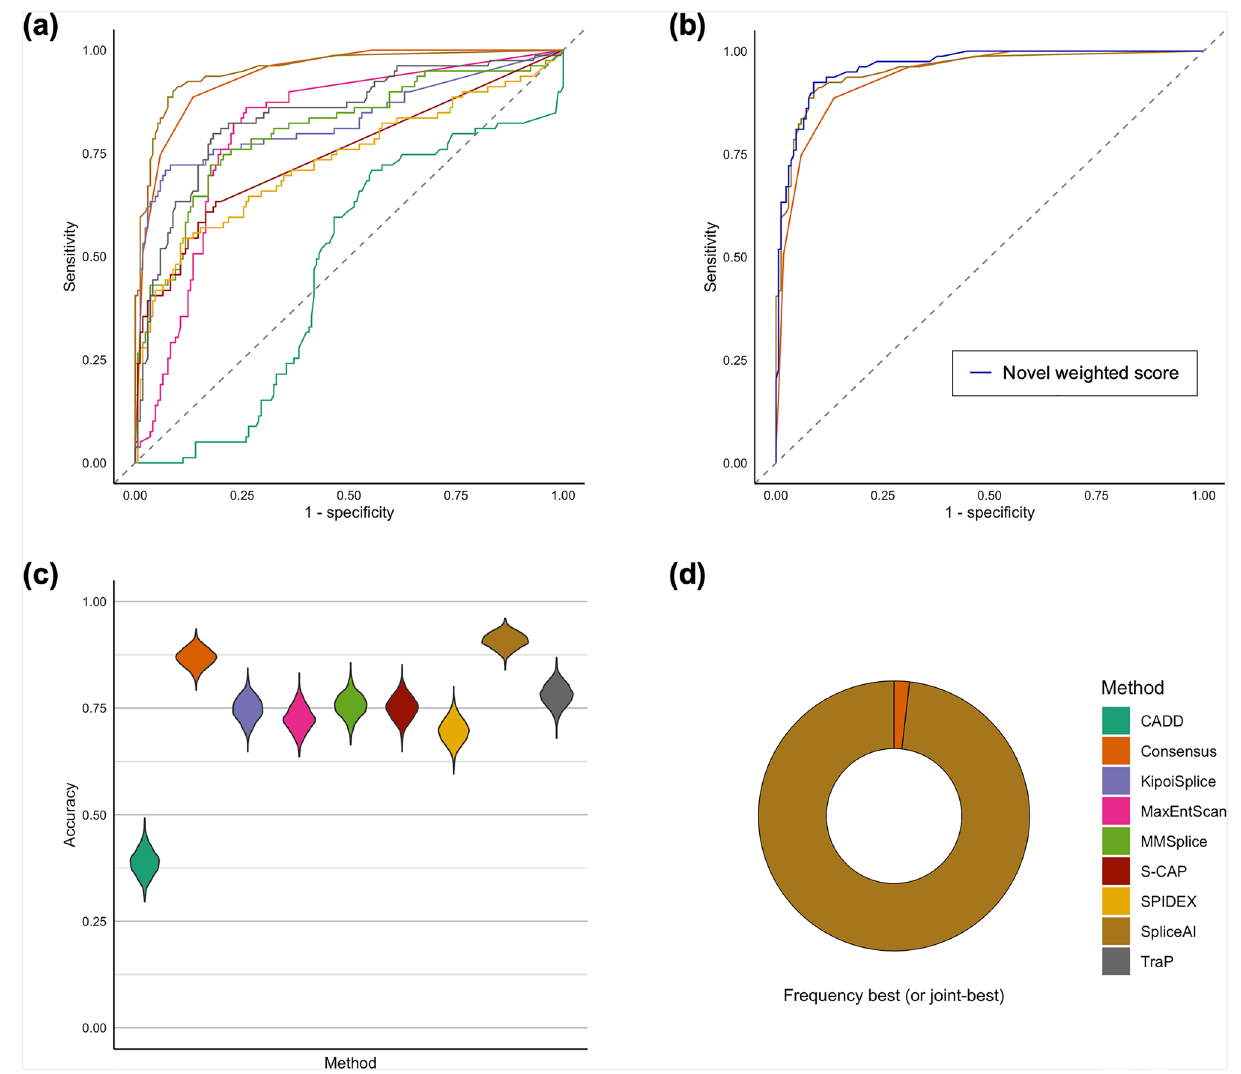
Figure 2. Comparison of in silico strategies to prioritize 249 variants of uncertain significance with functional investigations performed. ( a ) Receiver operating characteristic area under the curve (AUC) comparisons for nine in silico prioritization strategies demonstrating that SpliceAI (AUC = 0.95, 95%CI 0.92–0.97) and a consensus approach (AUC = 0.94, 95% CI 0.91–0.97) outperform other strategies for prioritization; ( b ) AUC comparisons between SpliceAI, a consensus approach and a novel metric, demonstrates that a weighted approach slightly increases accuracy of prioritization over single approaches alone (AUC = 0.96, 95% CI 0.94–0.98); ( c , d ) Accuracy comparisons of each in silico prioritization approach across 2000 bootstraps utilizing region-specific pre-defined thresholds: ( c ) Violin plot demonstrating the calculated accuracy of each in silico prioritization approach; ( d ) frequency that each strategy is the best or joint-best